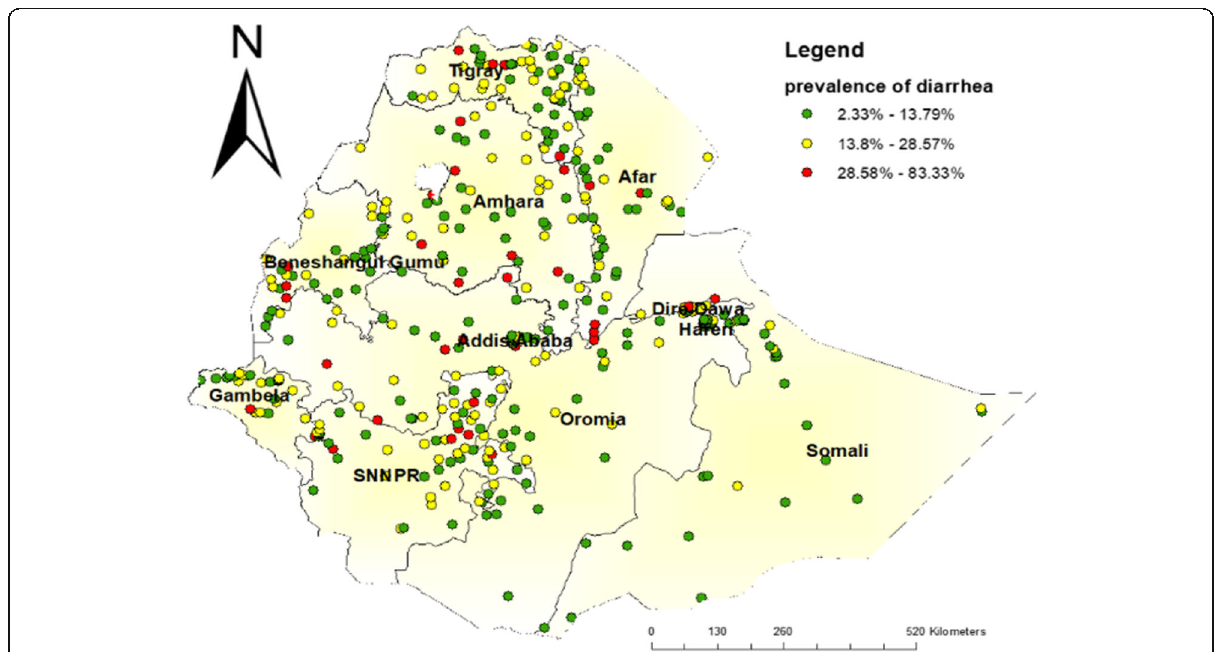
Fig. 1 Spatial distribution of childhood diarrheal disease among under 5 years of age children in Ethiopia, EDHS